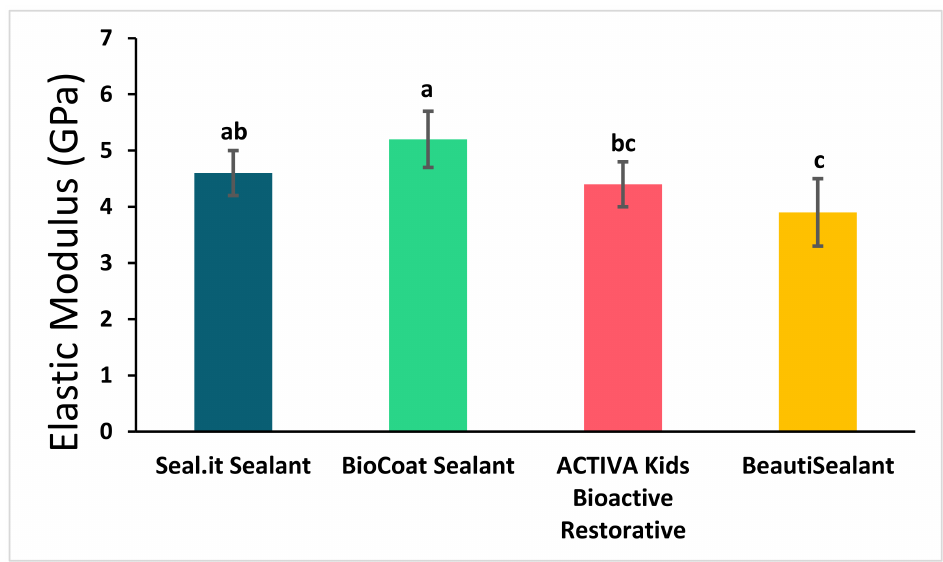
Figure 3. Elastic modulus of the studied sealants (mean ± SD). Values indicated by different letters (a–c) are statistically significant and different from each other ( p < 0.05). Table 2. Means ± SD of flexural strength, elastic modulus and surface hardness change (%).